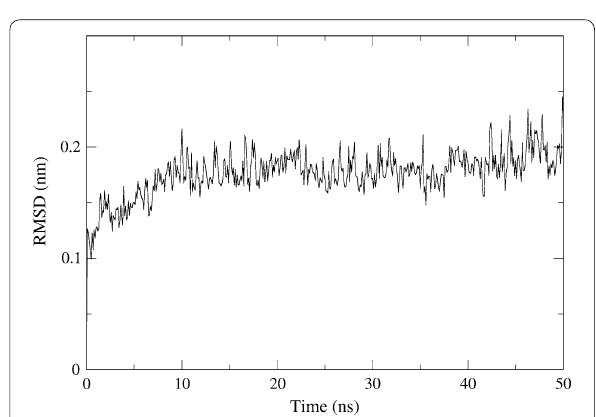
Fig. 4 RMSD values of protein backbone of STE/STE20/YSK protein kinase homology model during 50 ns MD